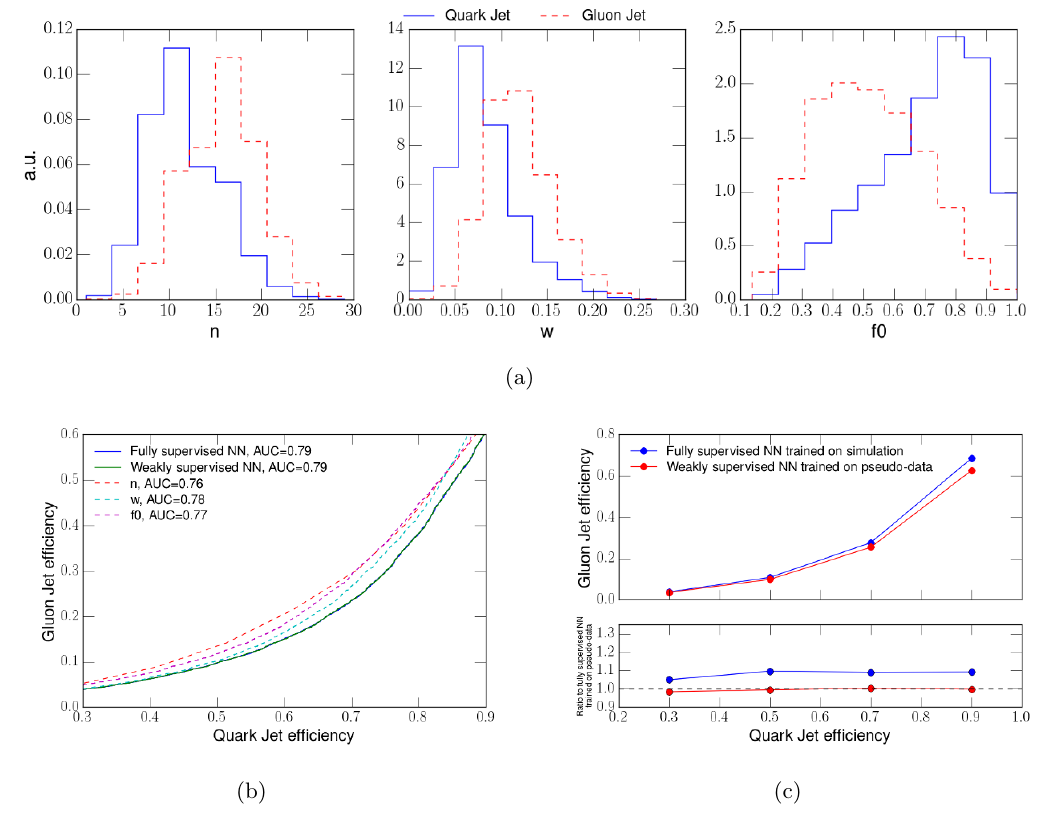
Figure 3 . Distributions of the discriminating features n , w and f 0 (a) and comparison of ROC curves for quark/gluon jet discrimination using a fully supervised classi(cid:12)er or a weakly supervised classi(cid:12)er. In (b) the fully and weakly supervised classi(cid:12)ers are trained on identical simulated data and evaluated on a test sample drawn from the same population. The weakly supervised classi(cid:12)er matches the performance of the fully supervised one. The curves corresponding to the three input observables used as discriminant are shown as reference. In (c), the fully supervised classi(cid:12)er (blue line) is trained on a labeled simulated training sample. The weakly supervised classi(cid:12)er (red line) is trained on an unlabeled pseudo-data training sample. In both cases, the performance is evaluated on the same pseudo-data test sample. The ratios to the performance of a fully supervised classi(cid:12)er trained on a labeled pseudo-data sample are shown in the bottom